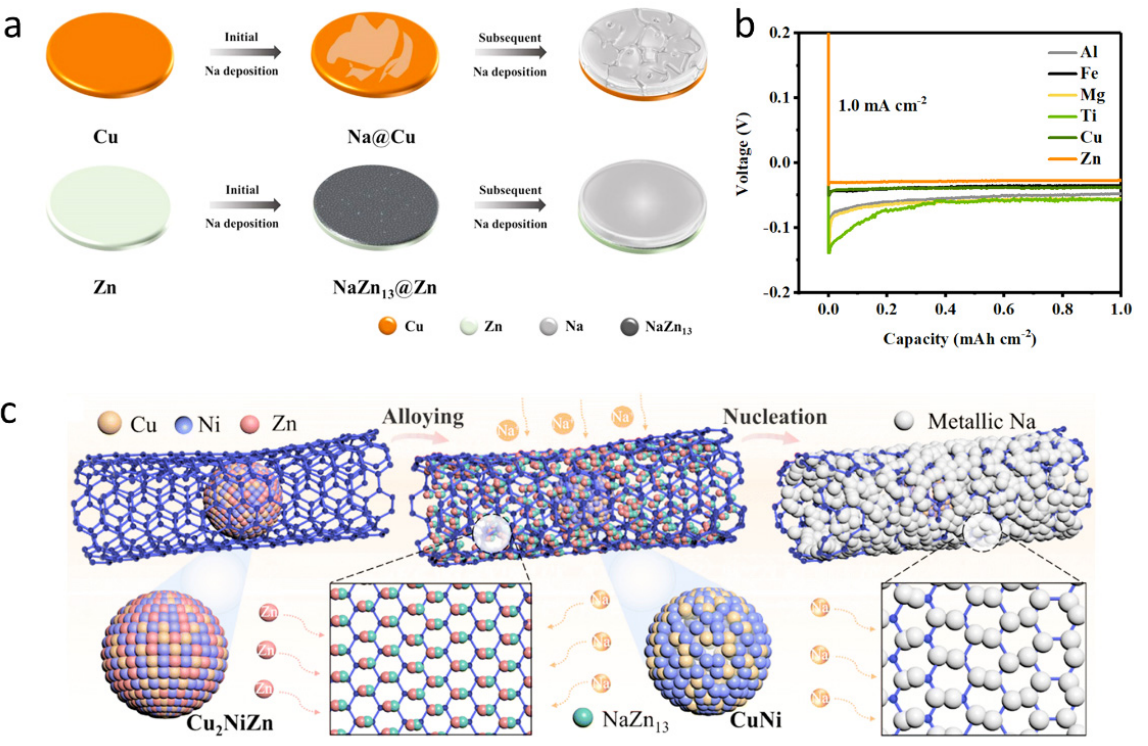
Figure 8. Illustration of the strategies for constructing sodiophilic alloys. ( a ) Schematic diagram of the Na deposition behavior at first and the subsequent cycles on the bare Cu foil and Zn foil; ( b ) the sodium deposition voltage profiles on the different current collectors at current density of 1.0 mA cm − 2 [84]; copyright 2022, IOP Publishing. ( c ) Illustration of the Na deposition mechanism within the Cu 2 NiZn@CNT substrate [87]. Reproduced with the permission of ref. [87], Royal Society of Chemistry, copyright 2022.